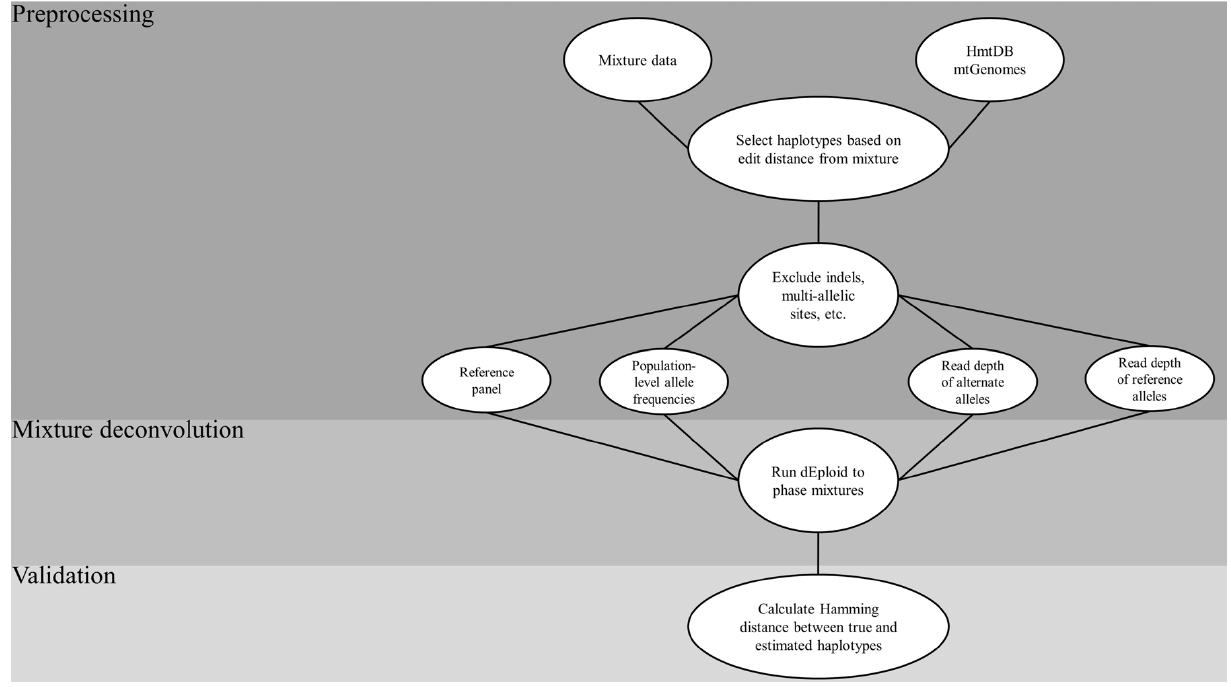
Figure 2. Flow chart of the general process employed in the mixture deconvolution simulation. HmtDB = Human Mitochondrial DataBase; mtGenomes = mitochondrial genomes; indels =